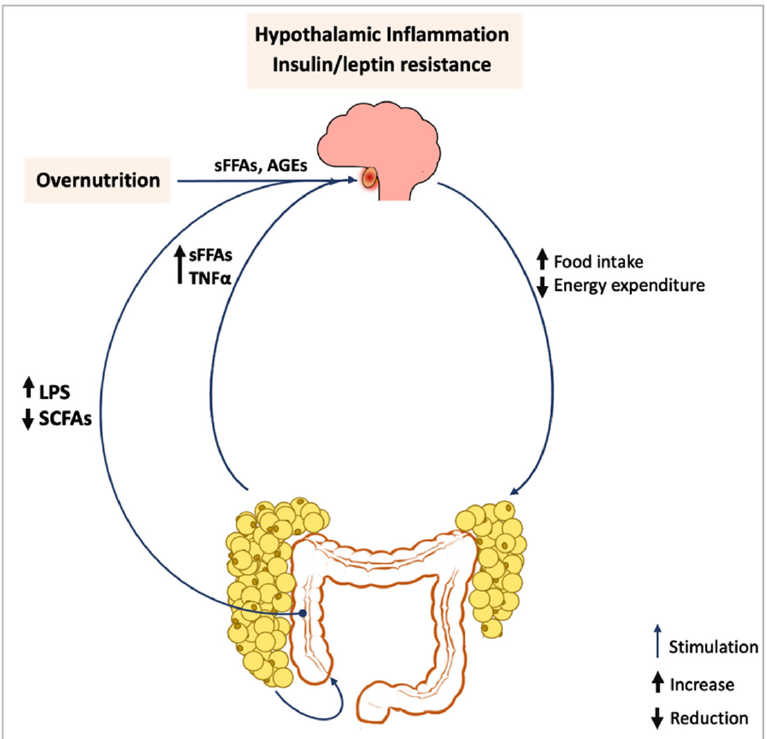
Figure 1. Obesity-associated disruption of hypothalamic functionality. AGEs, advanced glycation end-products; CCL-2 chemokine (C-C motif) ligand 2; LPS, lipopolysaccharide; SFCAs, short chain fatty acids; sFFAs, saturated fatty free acids; TNF α , tumor necrosis factor- α .